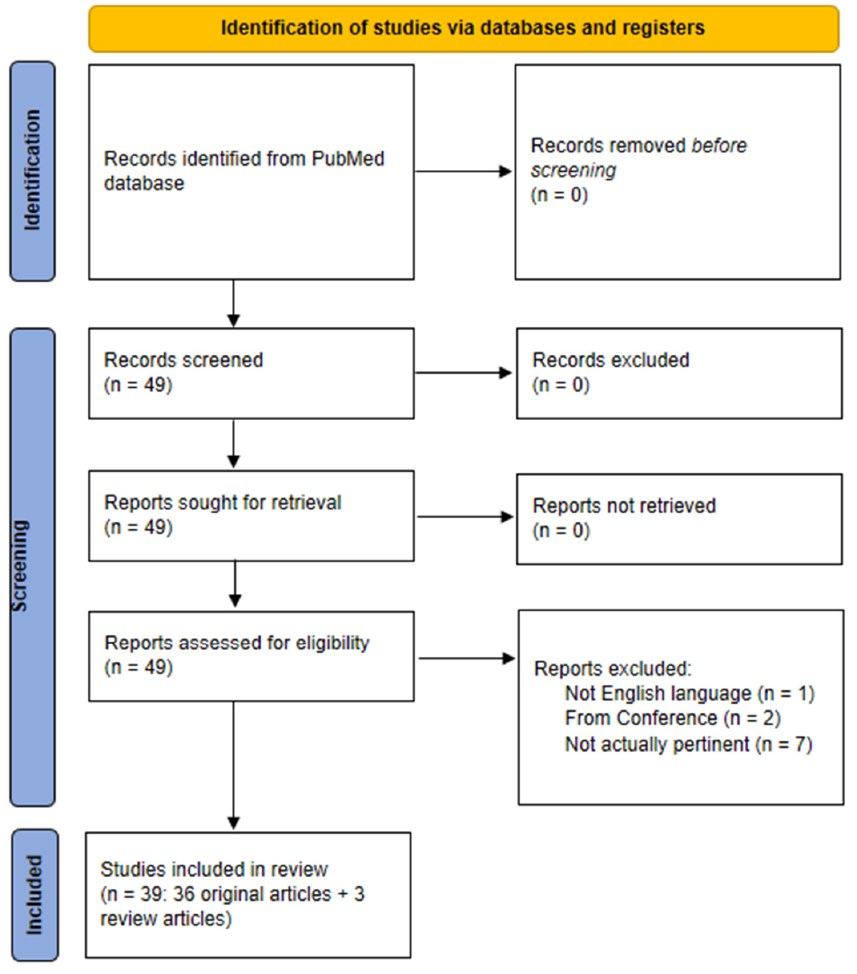
Figure 1. PRISMA flow diagram of the literature search strategy.